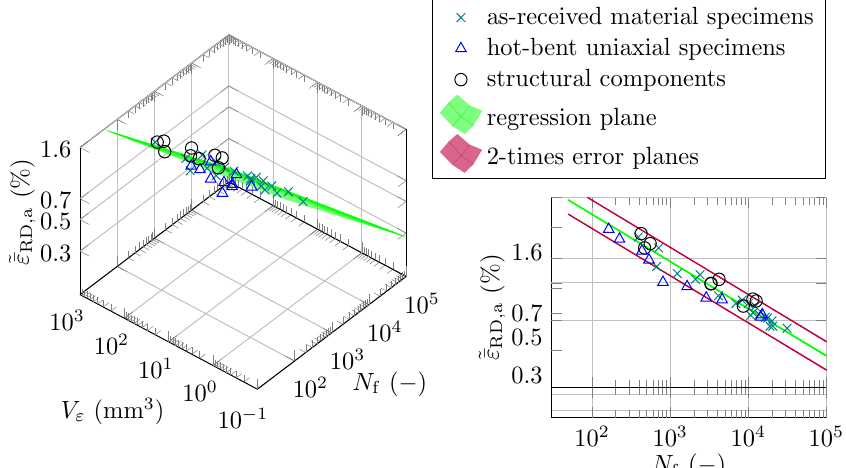
Figure 11. Three-dimensional and two-dimensional ˜¯ ε RD,a - V ε - N f fatigue diagrams by applying the CH ε V with regression parameters from results of low-cycle fatigue tests of the as-received mate- rial specimens.